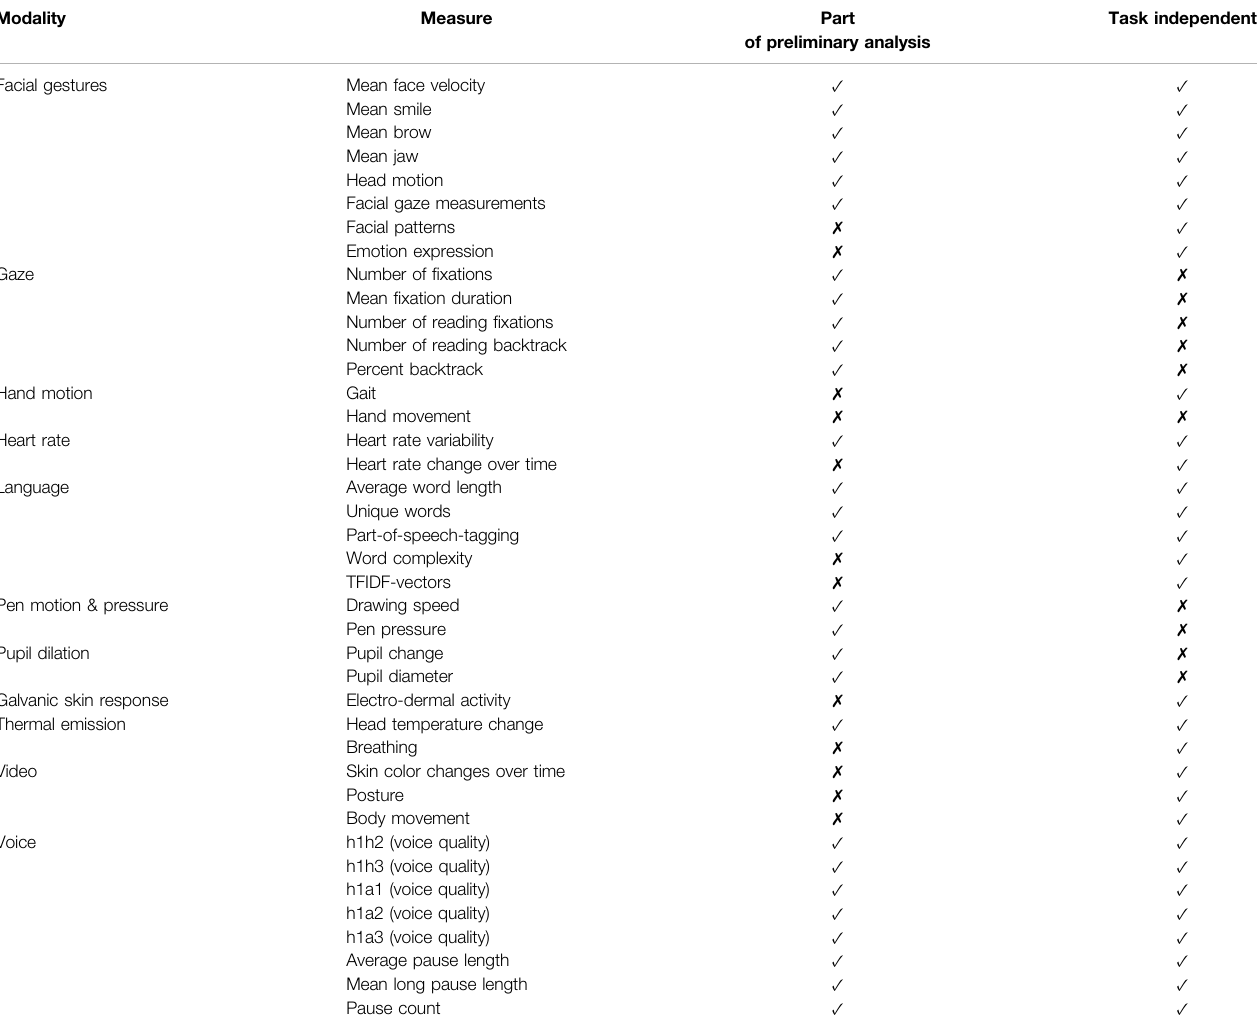
of preliminary analysis